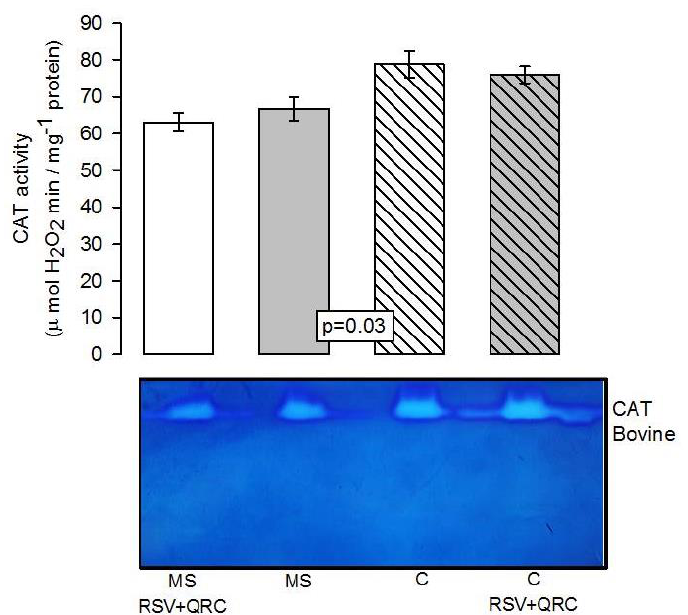
Figure 4. Densitophotometric analysis of catalase (CAT) activity in the liver homogenate in which the effect of treatment with the mixture of the RSV + QRC in experimental groups is shown. In the lower histogram, a native representative gel of the CAT activity is included. Abbreviations: MS = metabolic syndrome, C = control, RSV = resveratrol, QRC = quercetin. Data are expressed in means ± SE, ( n = 8, rats in each group).